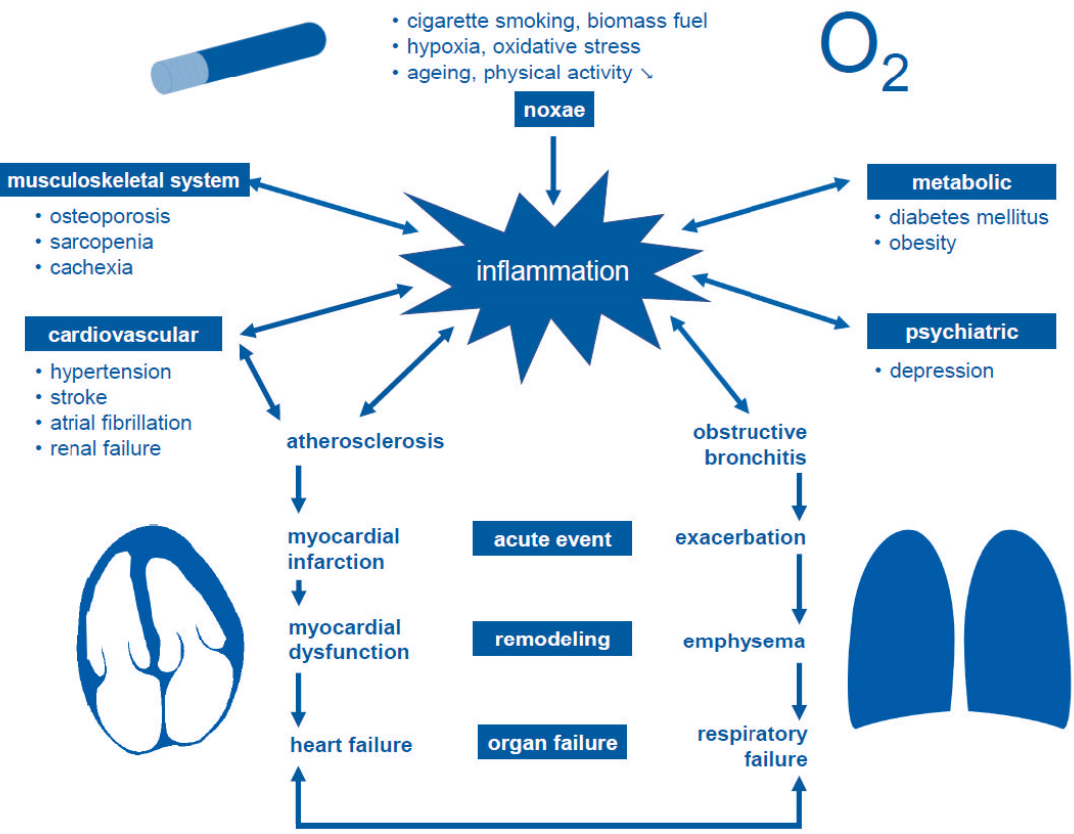
Figure 1. Cardiovascular and pulmonary disease in the context of inflammation (“cardiopulmonary continuum”, modified after [1,4]).